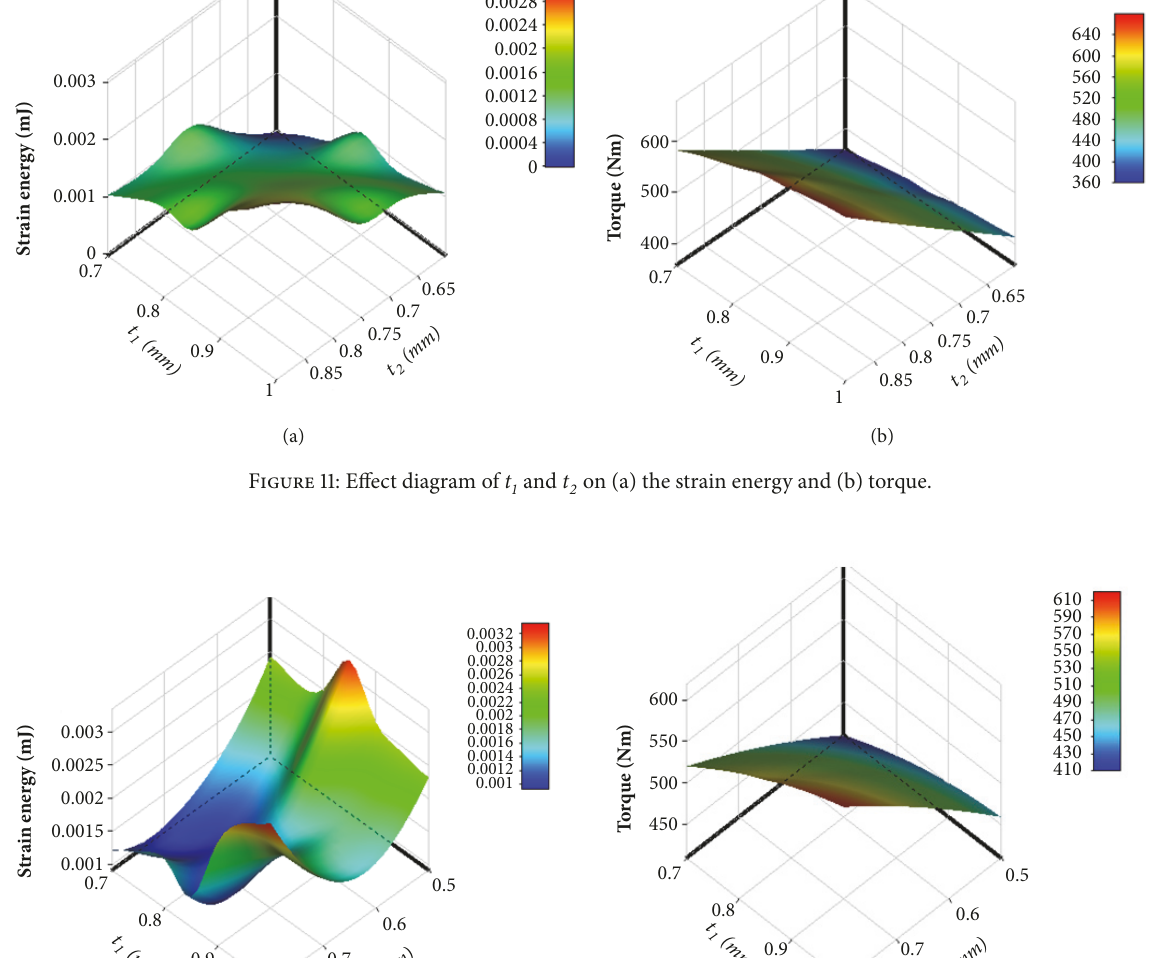
and t on (a) the strain energy and (b) 1 3